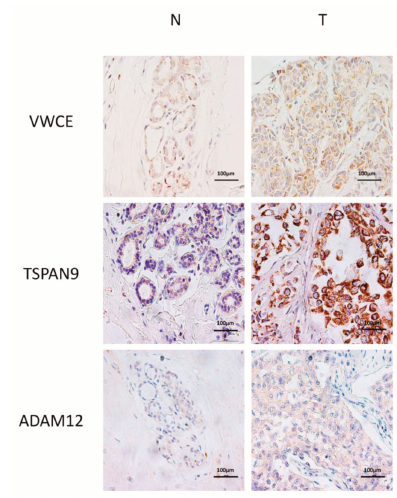
Figure 3. Representative IHC of non-neoplastic (N) and triple-negative breast cancer (T) tissues of VWCE, TSPAN9 and ADAM12 proteins. Images were acquired at 400 ×